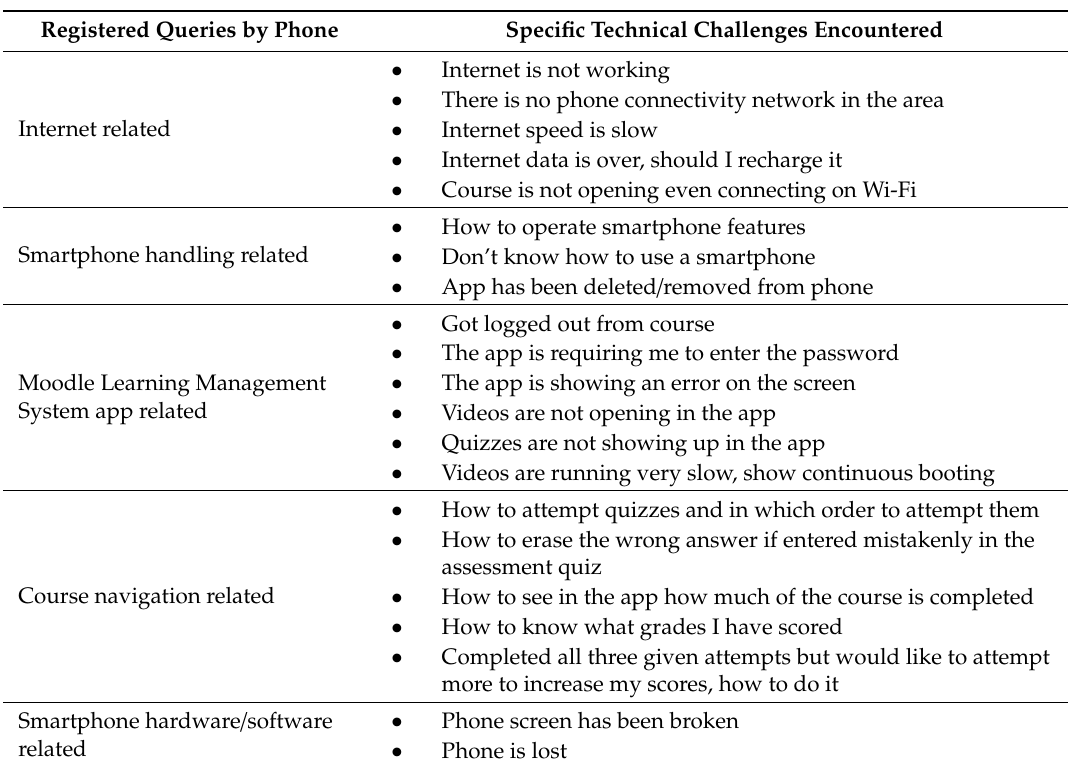
Table 3. Common technical challenges mentioned by participants during phone calls with the research team in the digital training